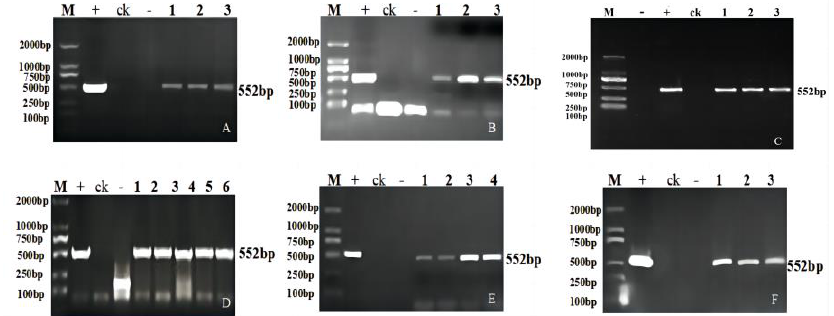
Figure 2. PCR detection of Cas9 in some T 1 generation transgenic plants: ( A ) 1 – 3 transgenic positive plants; ( B ) 1 – 3 transgenic positive plants; ( C ) 1 – 4 transgenic positive plants; ( D ) 1 – 7 transgenic pos- itive plants; ( E ) 1 – 4 transgenic positive plants; ( F ) 1 – 4 transgenic positive plants. M: DL2000 DNA marker; +: positive plasmid; -: negative control.